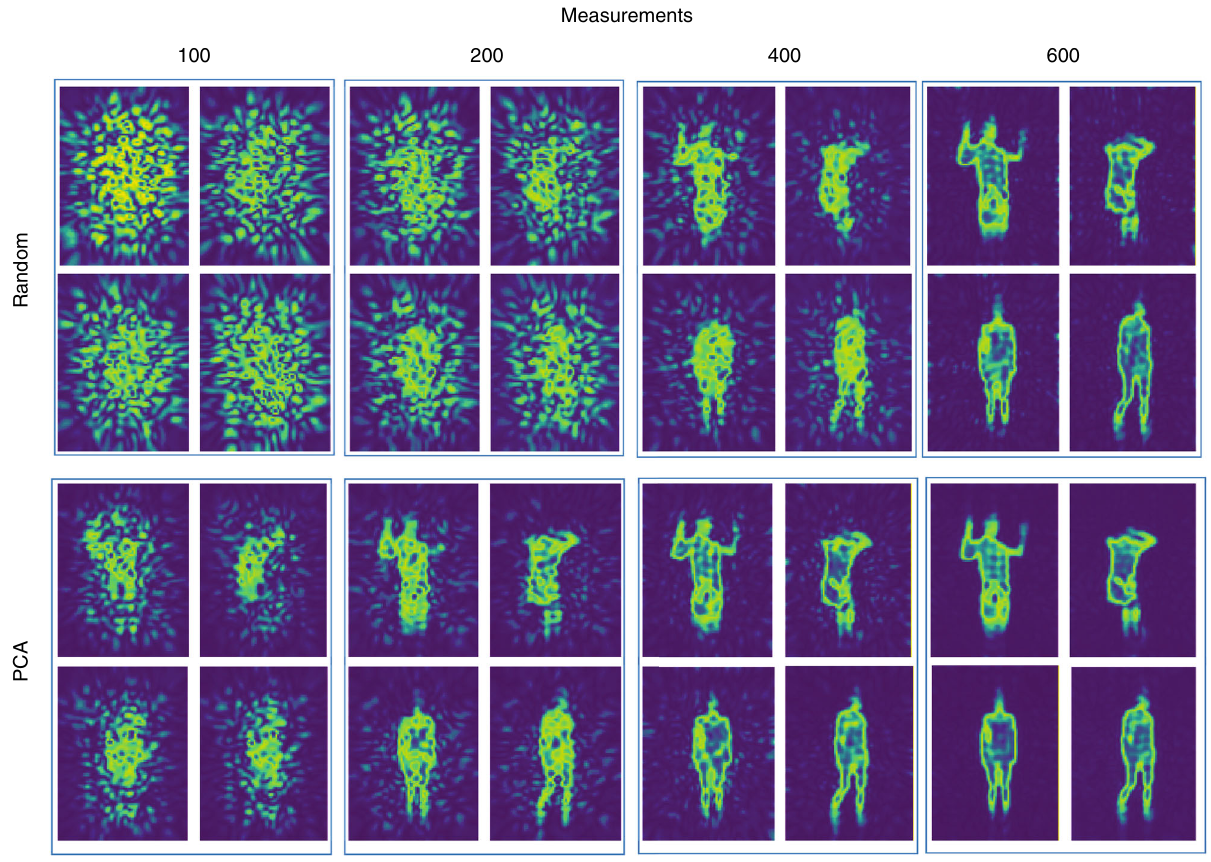
Fig. 3 Machine-learning-driven imaging results of four different cases in Fig. 2d. Different numbers of measurements, 100, 200, 400, and 600, were performed with linear embedding techniques of random projection and PCA. More detailed results are recorded in Supplementary Videos 3 and 4. This set of panels clearly demonstrates that the reconstructions by PCA have overwhelming advantages over those obtained by the random projection for small number of measurements, since a large amount of relevant training samples are incorporated in